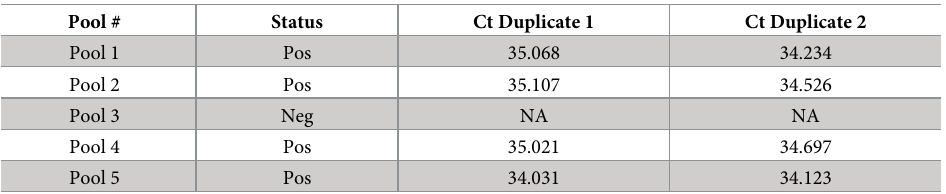
Table 1. N = 31 MHV-1 pooled testing qRT-PCR